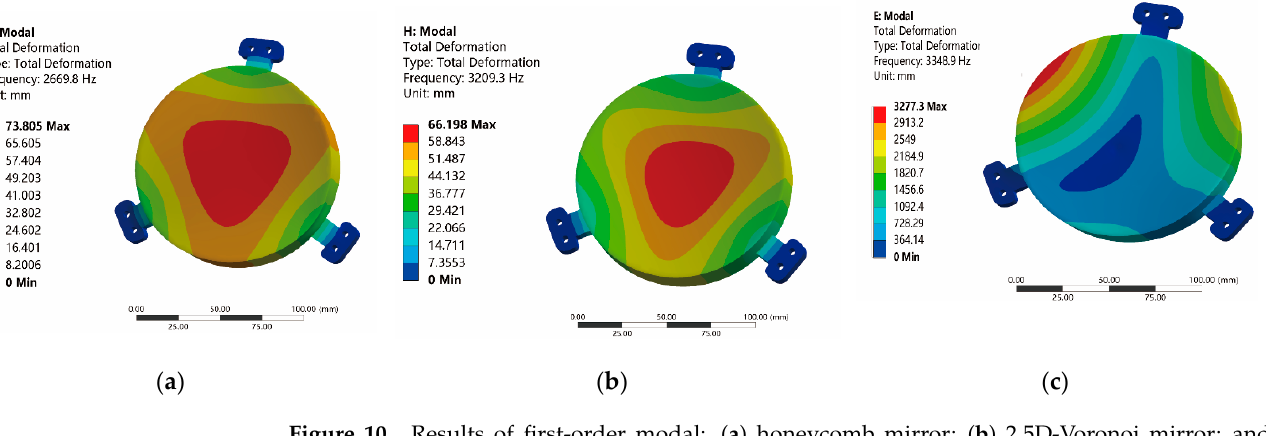
Figure 11. The front six modes and the corresponding frequency of the mirrors. 3.2. Forced Displacement Analysis First-order modal frequency is a direct response to structural stiffness. Nevertheless, the higher the structural stiffness, the greater the influence of external stress. Due to the integrated design of the mounting structure and mirrors, the screw tightening force can be transferred to the optical surface during integration and alignment, which affects the surface shape accuracy. Therefore, the forced displacement analysis was performed to evaluate the comprehensive optomechanical performance. The flexible structure was designed according to the surface shape accuracy requirements (Figure 12) and realized by the wire-electrode cutting technology after AM. It can isolate the influence of screw tightening force on the optical surface and absorb specific vibrations to realize the effect of unloading stress [11]. The deformations in multiple directions were considered to improve the mirror adaptability during the flexible structure design. At the same time, the distance between the mounting surface and the mirror should be increased as much as possible to extend the propagation distance of the tightening force and attenuate transmission.